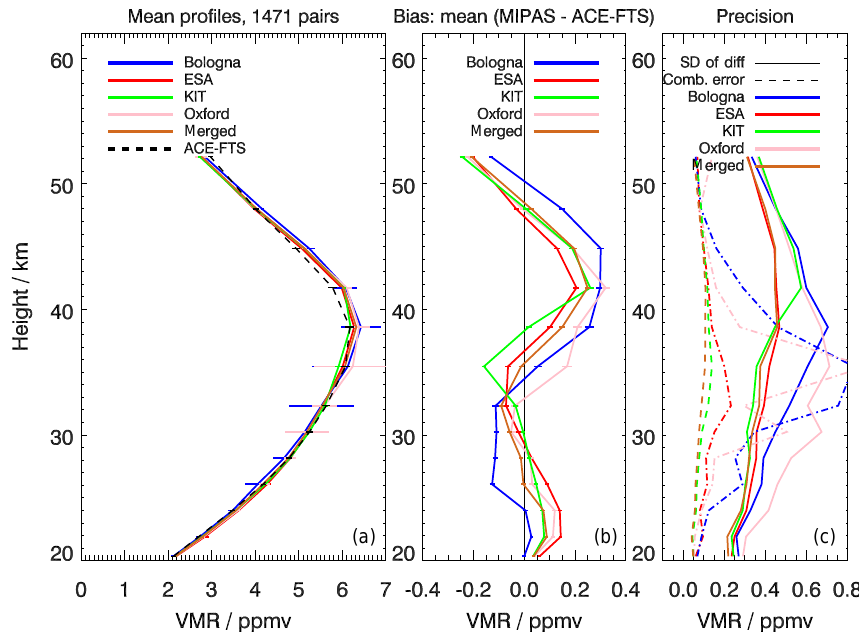
Figure 4. Mean profiles (a) , bias (b) , and precision validation (debiased standard deviation of the differences, c ) of the four parent datasets and merged MIPAS dataset with respect to ACE-FTS ozone profiles in 2007–2008.